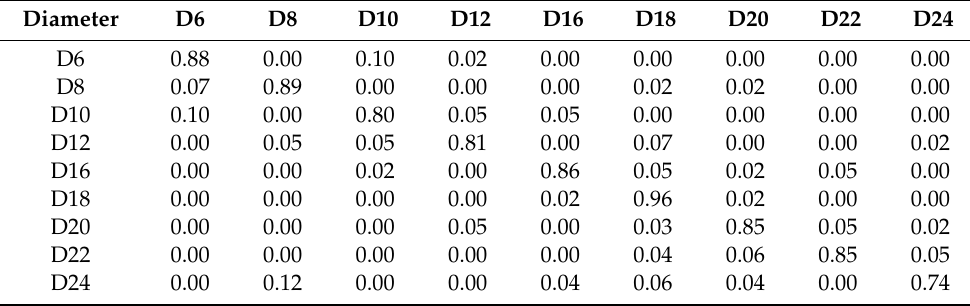
Table 8. Confusion matrix obtained by LSTM network on field